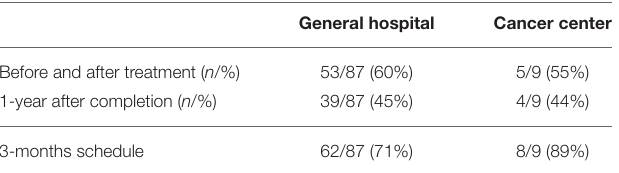
TABLE 1 | Frequency of routine cardiac evaluations in cancer patients receiving anthracyclines (upper panel) or trastuzumab (lower panel) by center type.